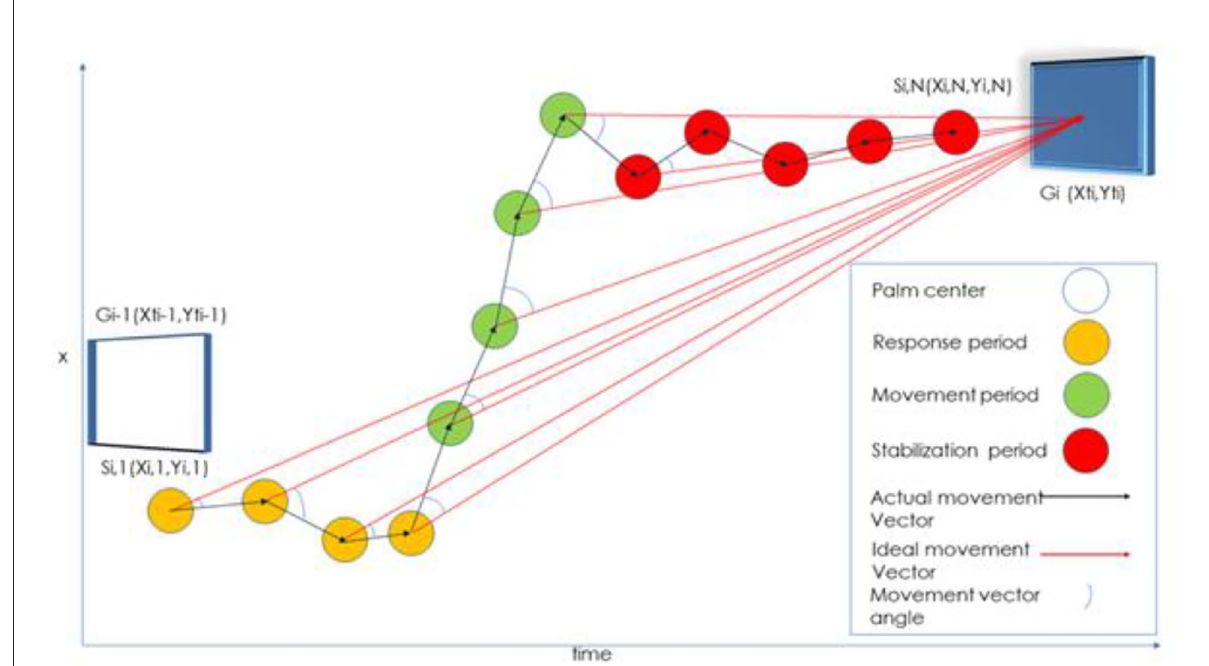
FIGURE9 Movement from gate Gi-1 to Gi. The Si,j represents the hand position on each j frame for every i window (Wi). Ideal movement vector is defined as the minimum distance between two consecutive gates (or points). This distance is used for analysis purposes as a benchmark (to observe the extent of hand movement deviations in comparison to an objective reference). It is not defined as the desired movement pattern (Chytas et al.,